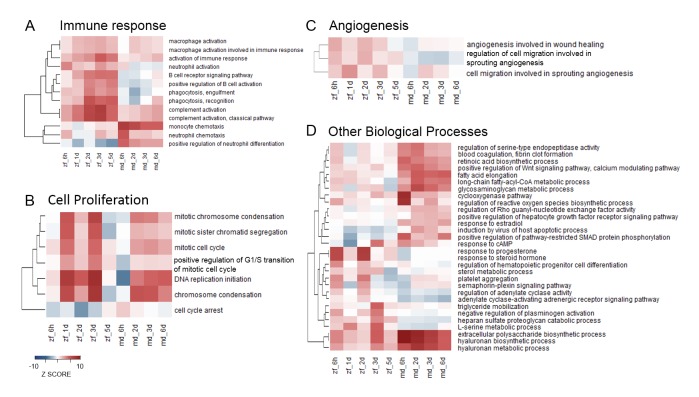
Heatmaps of enriched GO terms from SLEA.GO terms from SLEA analysis of sham-operated vs. untouched hearts related to immune response (A), cell proliferation (B), angiogenesis (C) and other biological processes (D), were selected and respective Z-scores visualized. Color scales were matched for all four heatmaps, ranking from –10 for underrepresentation to +10 for overrepresentation.